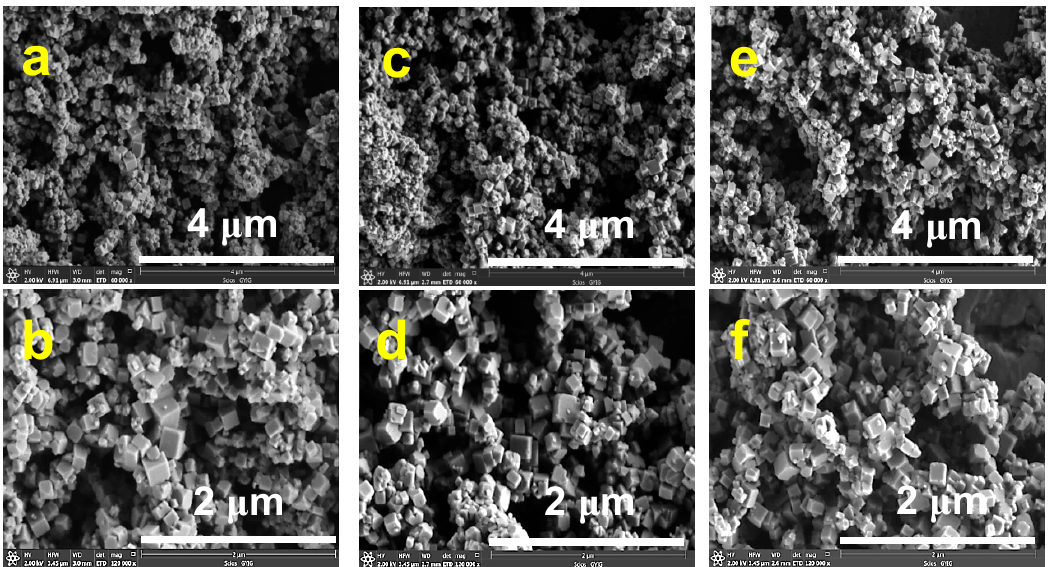
Figure 3. Scanning electron microscopy (SEM) images of the as-synthesized pyrite nanocrystals with 80 mmol/L thiourea as the sulfur source at 24 ( a , b ), 72 ( c,d ), and 168 h ( e,f ), respectively.